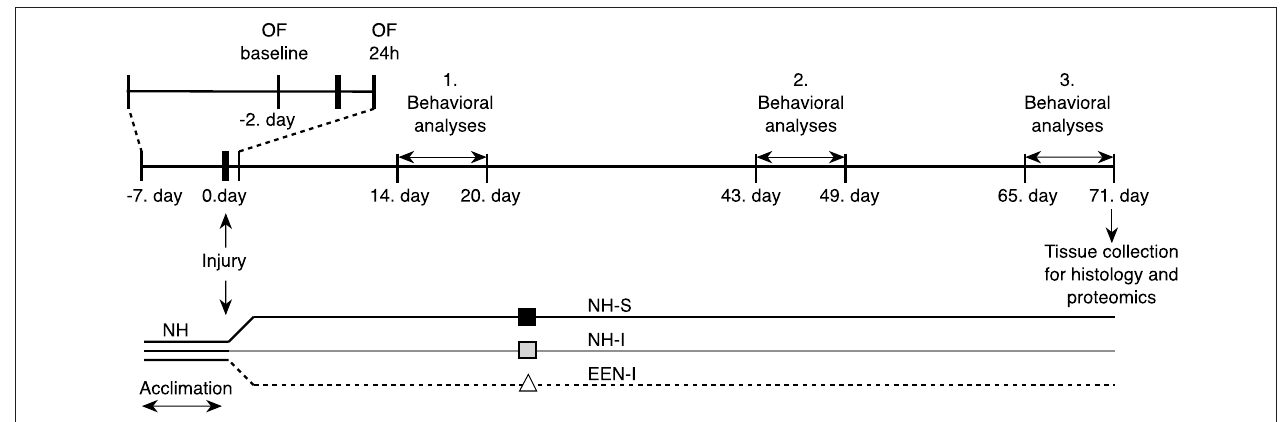
Figure 1 | Outline of the experimental